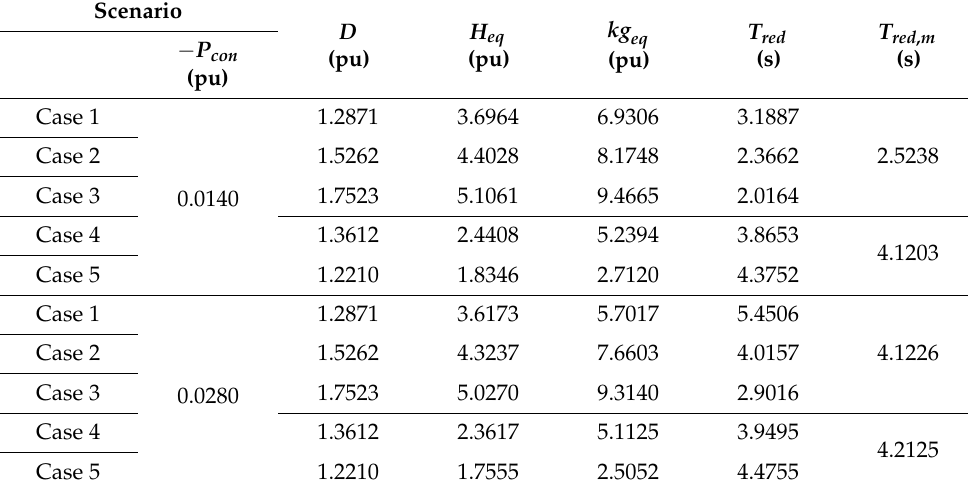
Table 1. RFR Model parameters in each